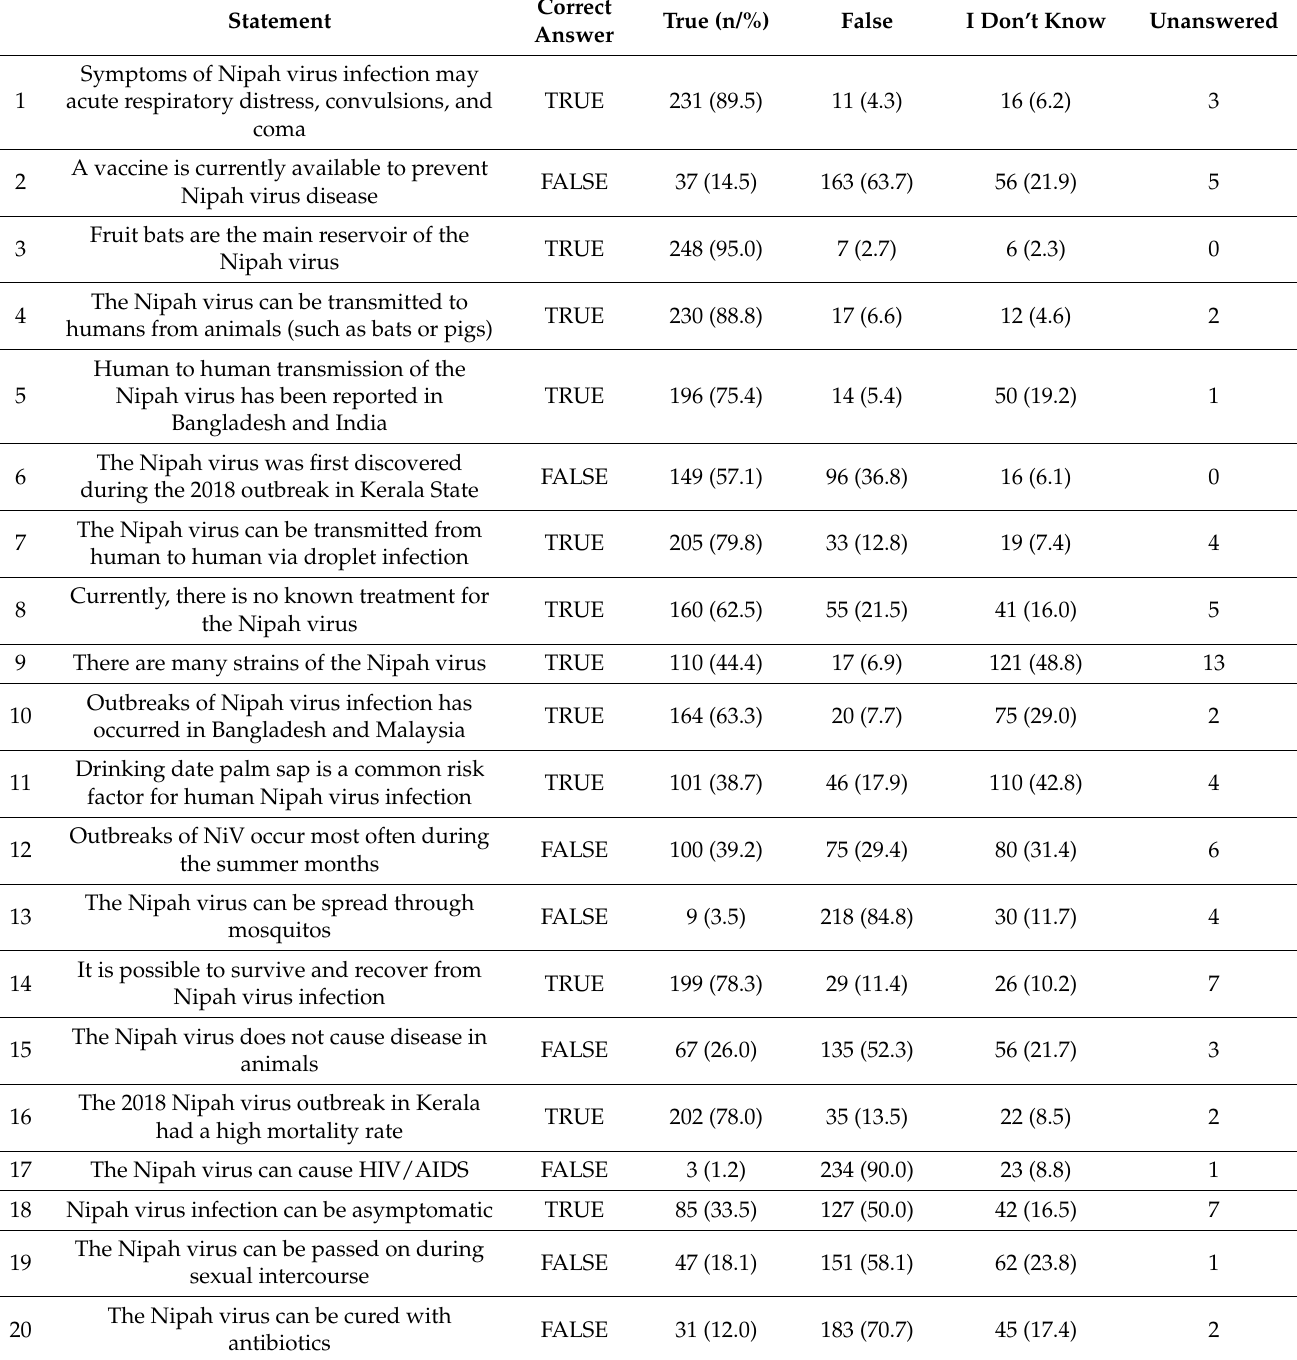
Table 2. Knowledge regarding Nipah virus transmission, risk factors, clinical presentation, and